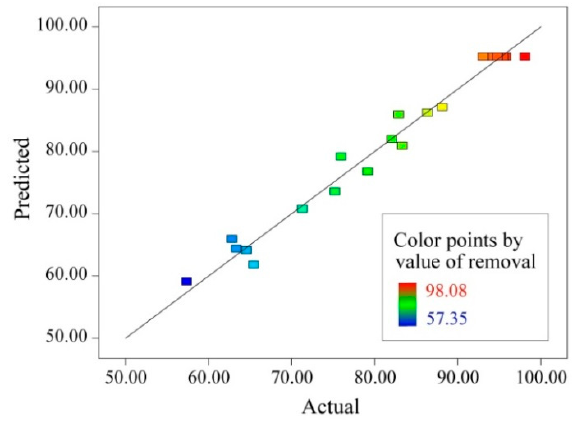
Figure 2. The predicted removal efficiencies versus the actual ones.